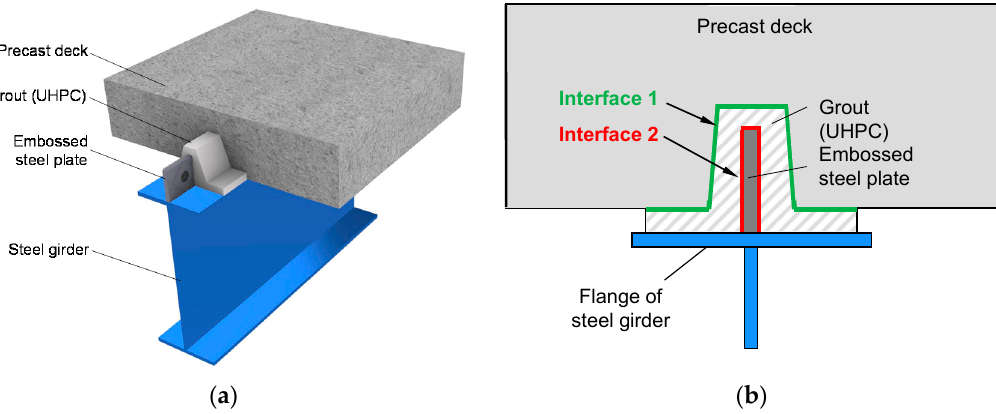
Figure 2. Schematic of strip shear connection: ( a ) general view; ( b ) interface details.